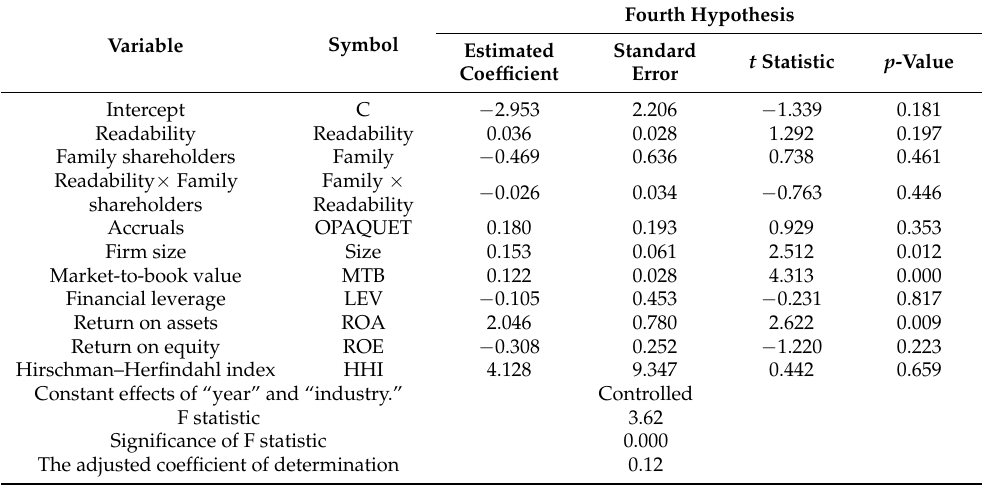
Table 7. The results of the fourth hypothesis